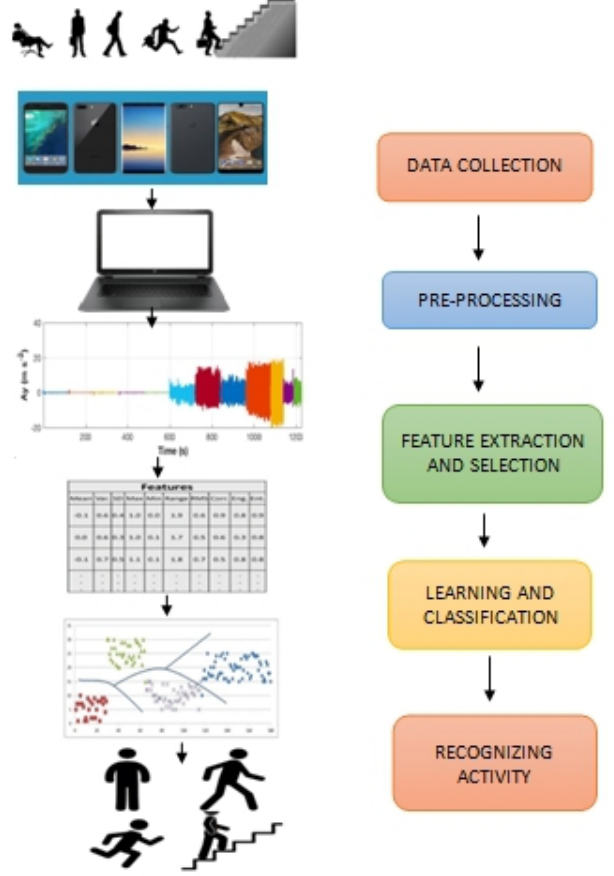
Figure 1. Overall data flow for detailed activity recognition system using